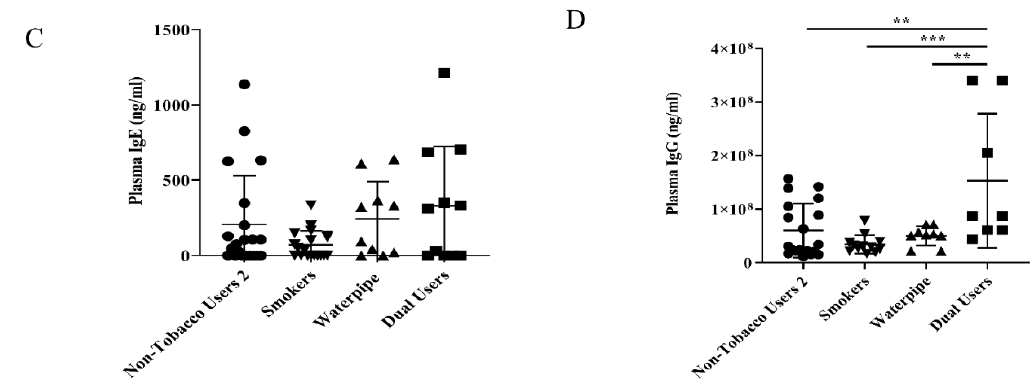
Figure 2. Plasma immunoglobulin levels in tobacco product users. ( A ) Plasma samples collected from either e-cigarette users or non-tobacco users 1 were measured for IgE levels following a 1:5 dilution